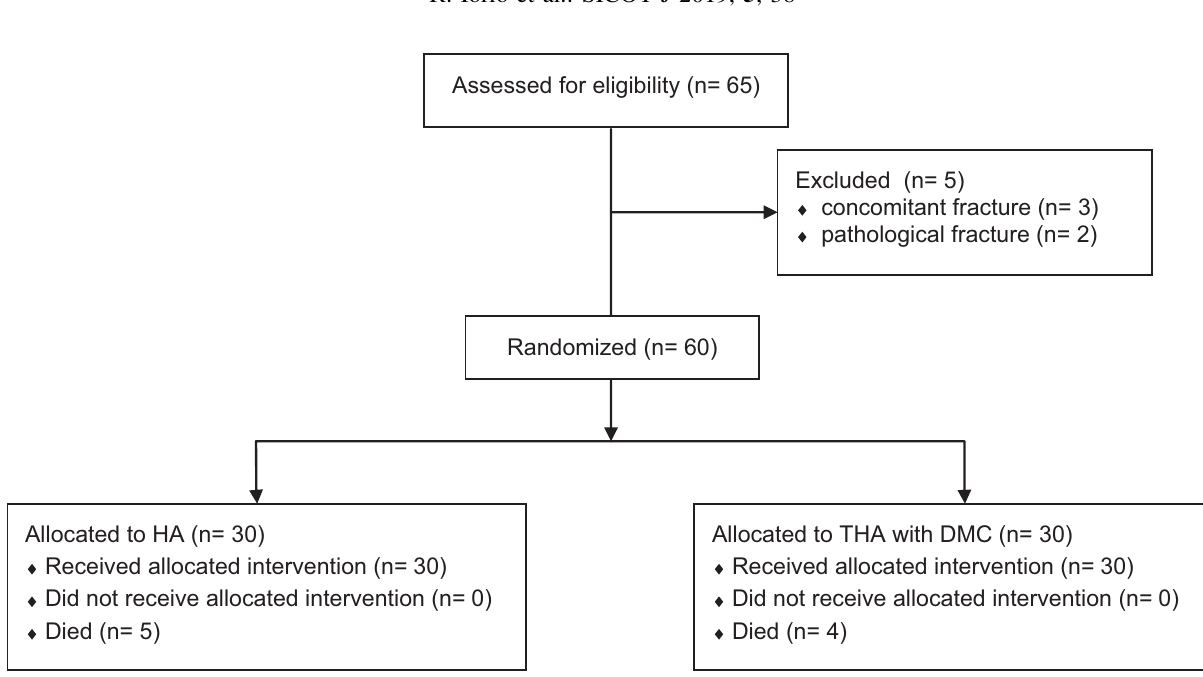
Figure 1. Participant fl owchart of the